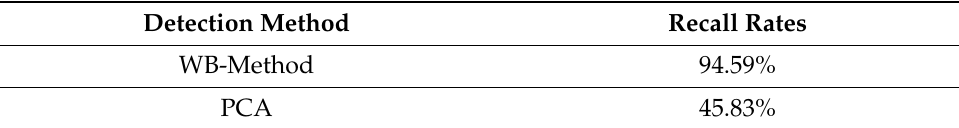
Table 2. Recall rate of leak detections ( C EM ∈ [ 0.2,0.6 ))